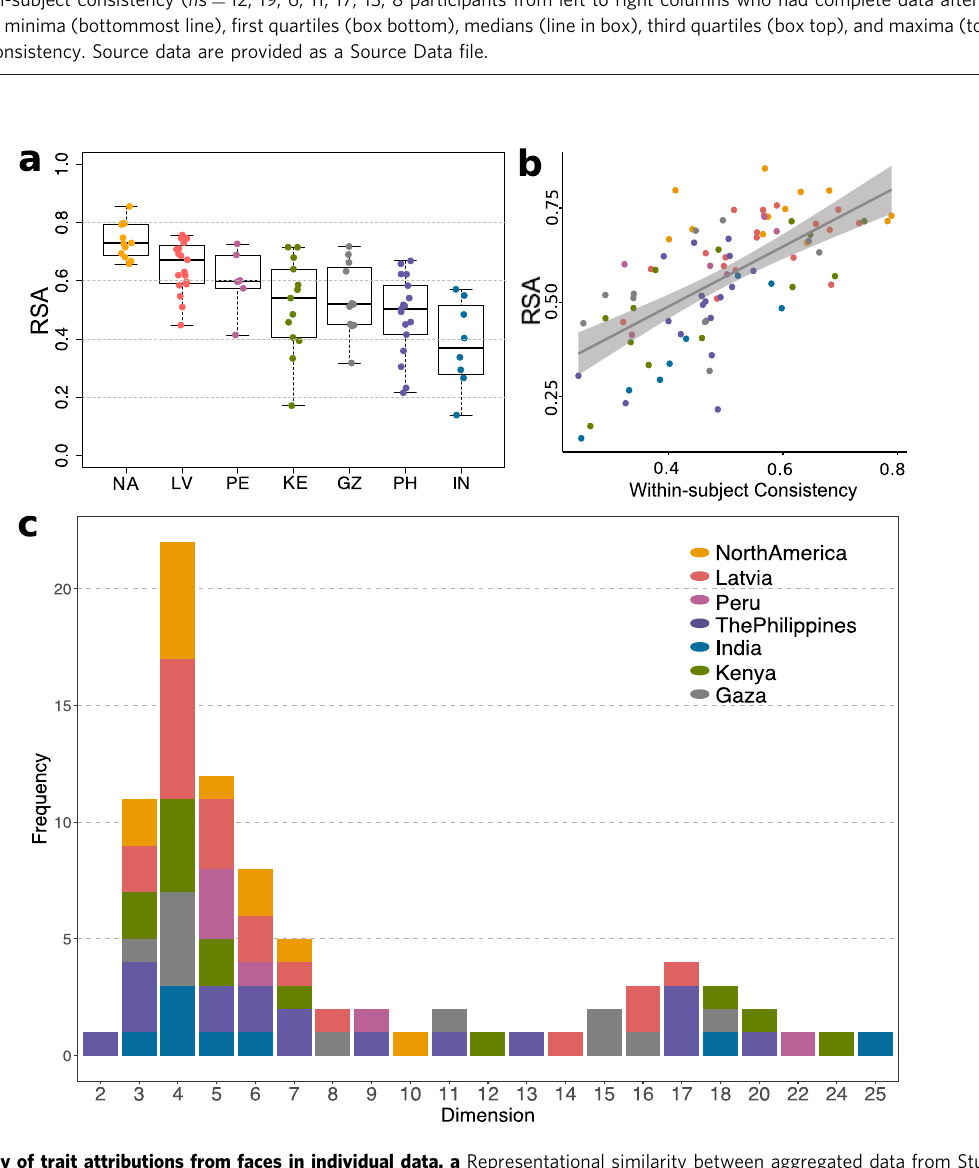
Fig. 7 Dimensionality of trait attributions from faces in individual data. a Representational similarity between aggregated data from Study 1 and individual-level data from Study 2 for individuals who had complete data after exclusion ( n = 86, see Methods). Colors indicate different samples (as in Fig. 6). Boxplots indicate the minima (bottommost line), fi rst quartiles (box bottom), medians (line in box), third quartiles (box top), and maxima (topmost line) of RSAs. b Correlation between within-subject consistency and RSA ( r = 0.66, p = 6.476 × 10 − 12 ). Each point plots an individual ’ s within-subject consistency ( x -axis) and that individual ’ s RSA with the aggregated data in Study 1 (y-axis). The shaded area indicates the error band. c Distribution of the number of dimensions (from parallel analysis) across 86 individual-level datasets. Source data are provided as a Source Data fi